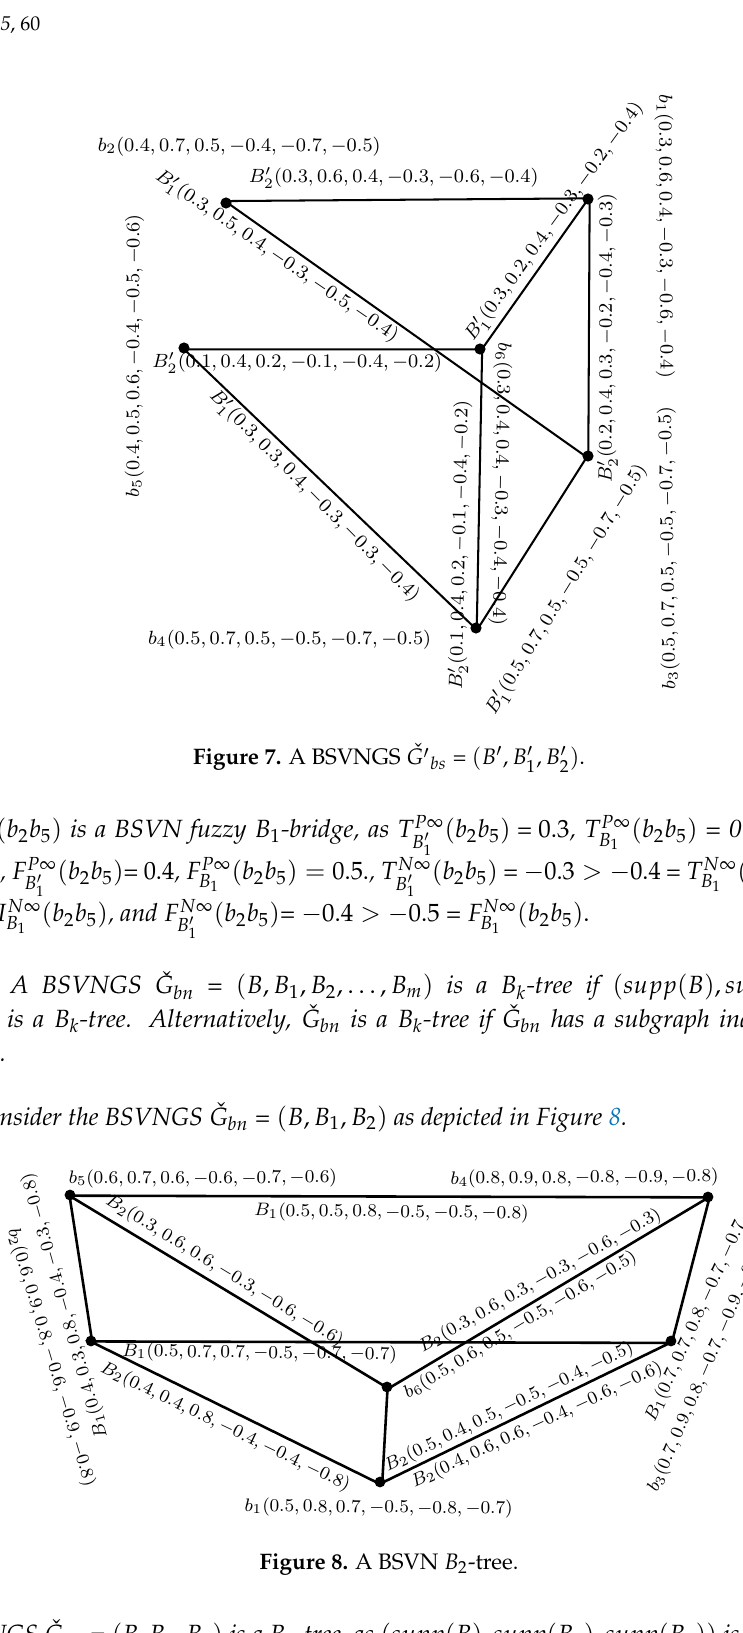
Figure 8. A BSVN B 2 Figure 2.8: A bipolar single-valued neutrosophic B Figure 2.8: A bipolar single-valued neutrosophic B